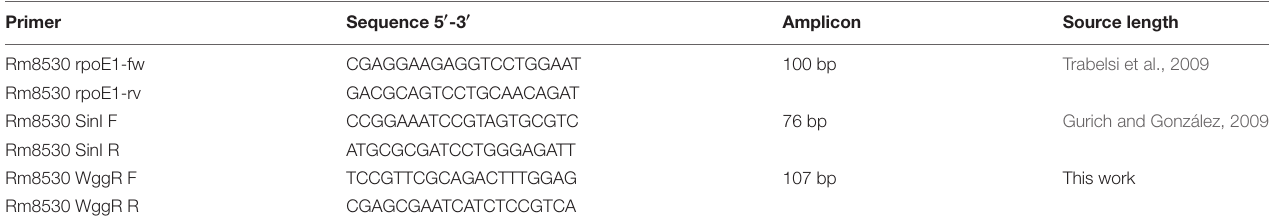
TABLE 2 | Primer sequences used in this